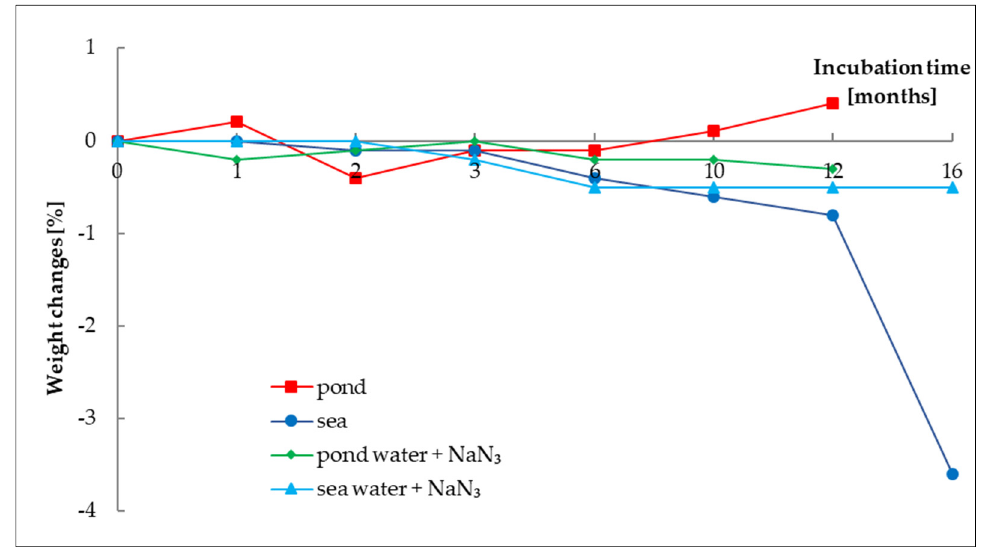
Figure 2. Weight changes [%] of PLA samples after incubation in different aqueous environments. Source: Own research.